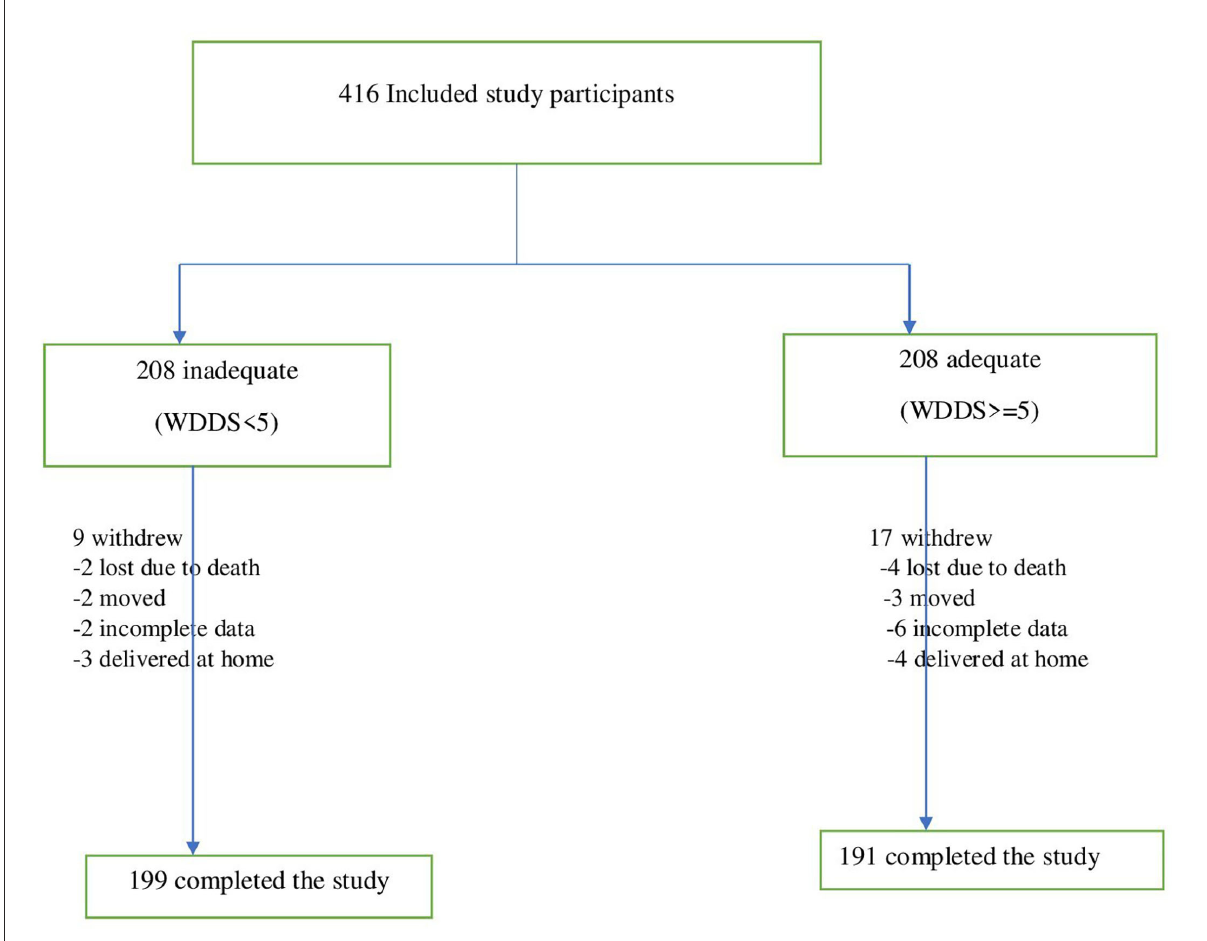
FIGURE1 Revealed cohort of pregnant mothers follow-up procedure at east Gojjam zone, northwest Ethiopia, 2019/2020.